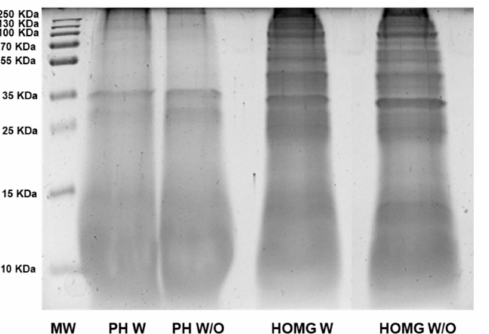
Figure 2. SDS-PAGE of proteins from Anemonia sulcata with (W) and without (W/O) its microalgal symbiont Symbiodinium . The protein hydrolysates were compared to the crude homogenates to observe different patterns of proteins, indicating that the enzymatic digestion had been carried out correctly. Molecular weight (MW); protein hydrolysates (PH); crude homogenates (HOMG).